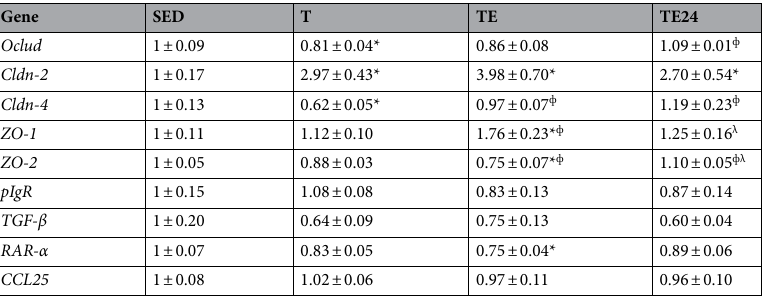
Table 2. Changes in gene expression of some molecules in small intestine compared to the sedentary group. SED sedentary rats, T trained rats, TE T rats with a final exhaustion test, TE24 TE rats 24 h after the final exhaustion test. Data are expressed as mean ± standard error (n = 8). Statistical differences (Kruskal–Wallis followed by Mann–Whitney U test): *p < 0.05 vs SED group; ф p < 0.05 vs T group; λ p < 0.05 vs TE group.